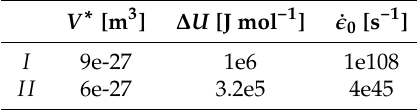
Table 2. Eyring parameters for α -I.